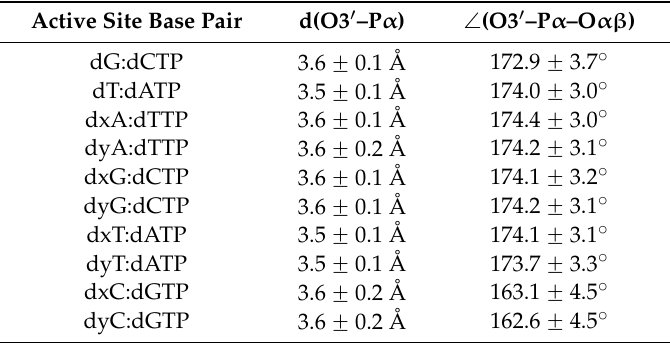
Table 2. Average and standard deviation of the reaction distance and angle during 40 ns MD simulations of the Dpo4 ternary complex for the replication of a DNA, xDNA or yDNA base.